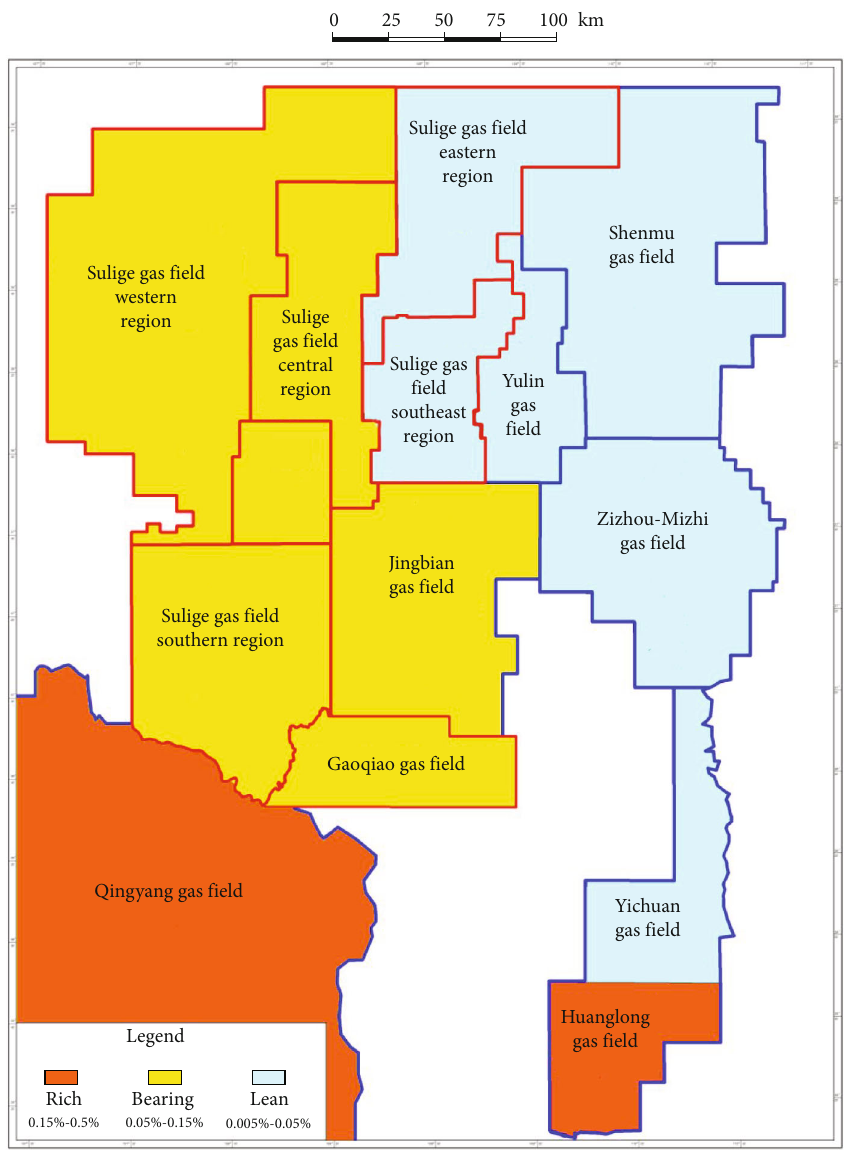
Figure 6: Distribution of helium in Changqing Gas